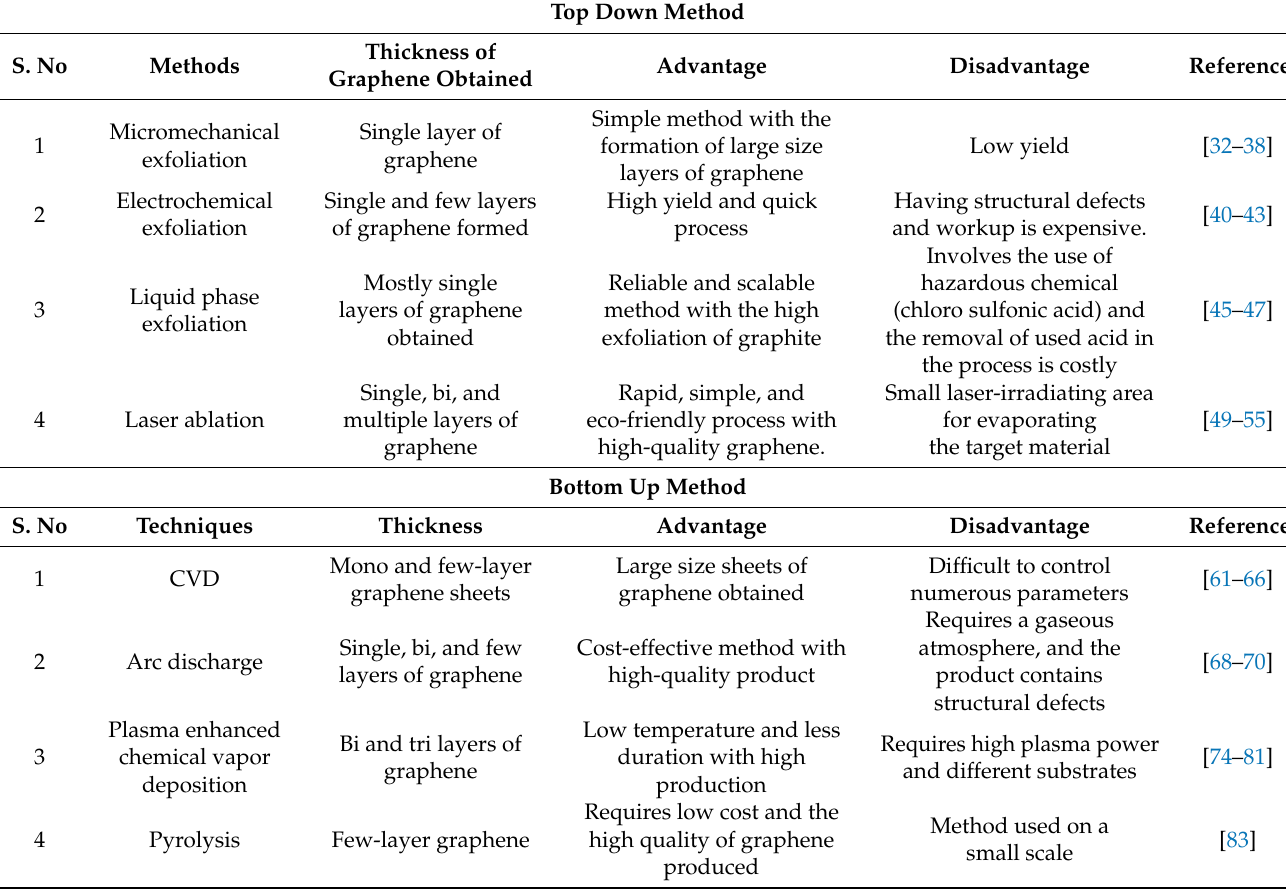
Table 1. Advantages and disadvantages of various methods used to synthesize